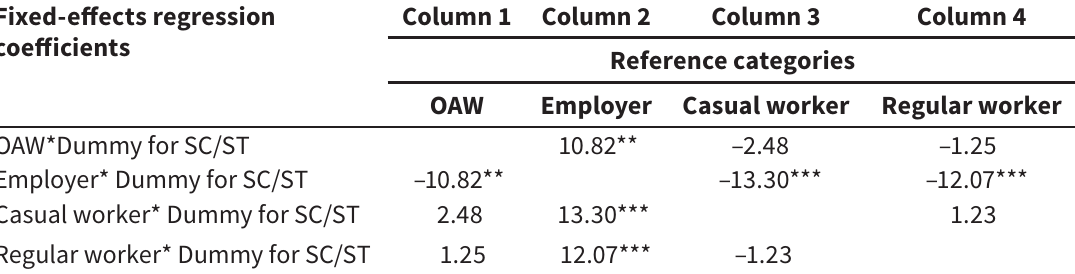
Fixed-effects regression coefficients of the interaction between sectoral choice and caste